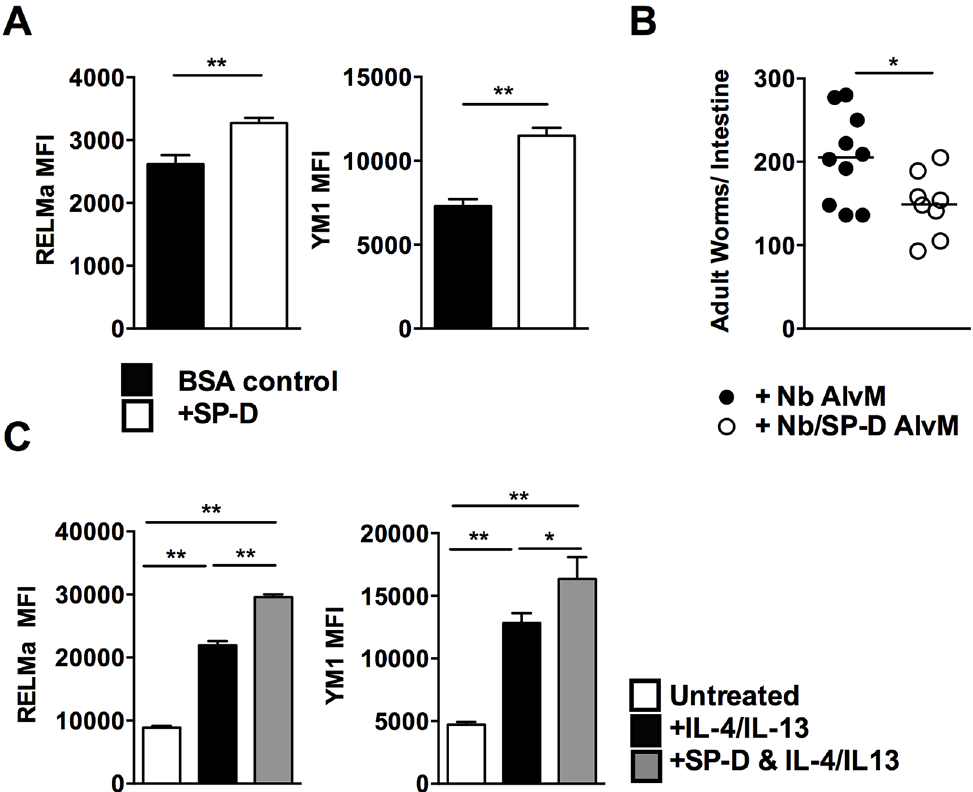
Fig 5. SP-D-induced protection is mediated by enhanced alternative activation of alveolar macrophages. Mean fluorescence intensity (MFI) of Ym1 and RELM- α expression on alveolar macrophages at day 5 PI rfhSP-D treated or untreated mice ( a ). Macrophages isolated from lungs of infected rfhSP-D treated or untreated mice were intra-nasally transferred into na ï ve BALB/c mice. Mice were then infected with N . brasiliensis and worm burdens were quantified at day 5 PI ( b ). 4 x 10 5 macrophages sorted from na ï ve lungs were cultured with either IL-4/IL-13 (black), rfhSP-D and IL-4/IL-13 (grey) or untreated (white) and RELM- α and Ym1 expression was quantified by FACS ( c ). Data are representative of 2 – 3 experiments. N = 5 – 8 mice per group. * P < 0.05, ** P < 0.01, *** P <